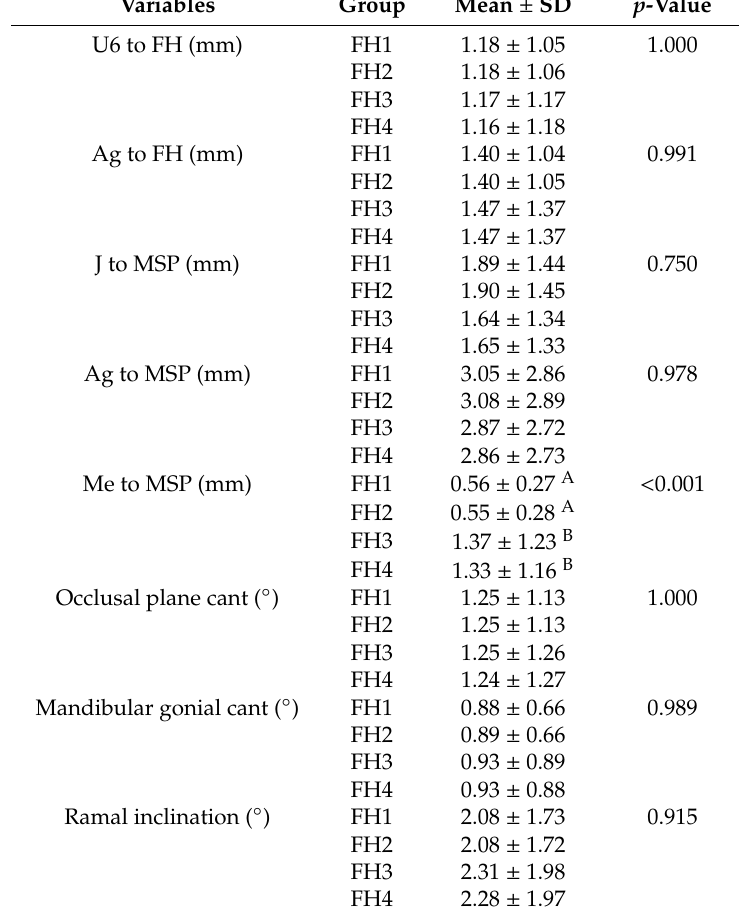
Table 4. Comparison of each variable according to each FH plane.